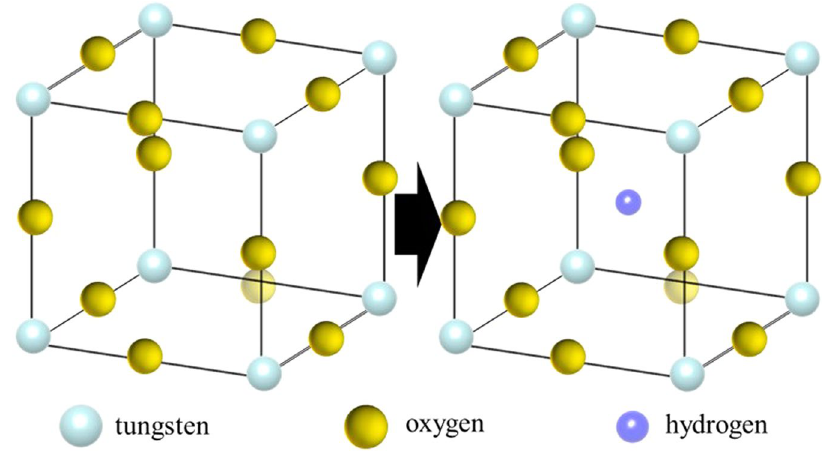
Figure 8. Drawings of the crystal lattice of WO 3 (left) and HWO 3 (right).